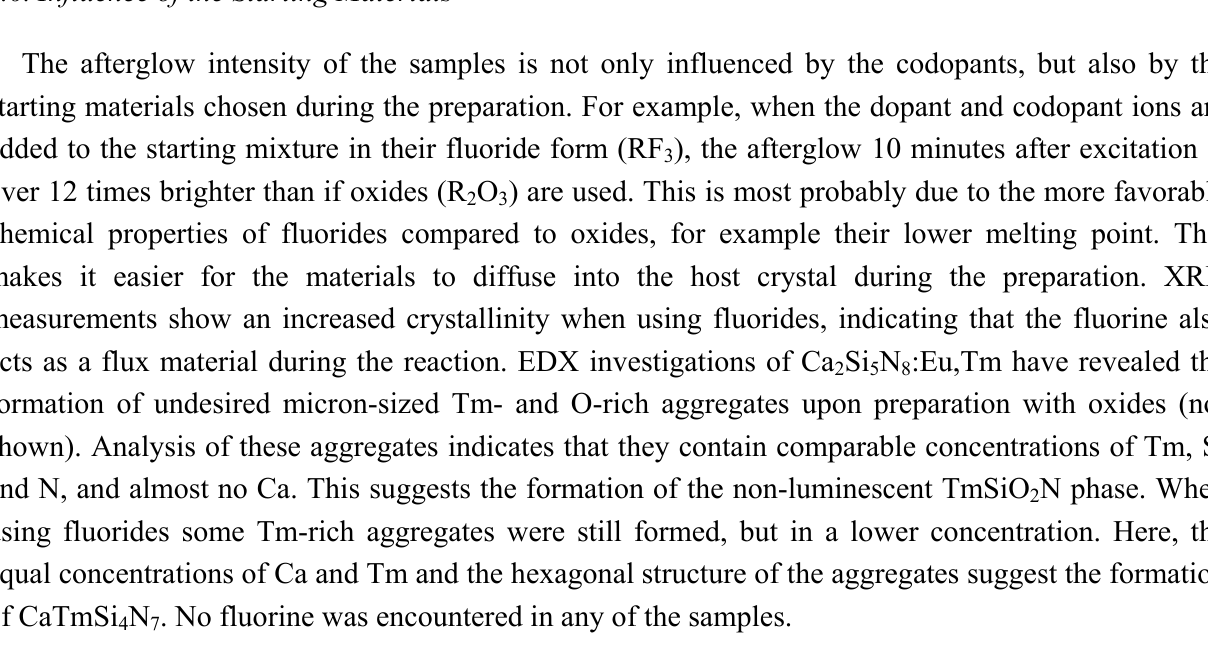
Si N :Eu,Tm. The samples were excited at room temperature for 2 5 8